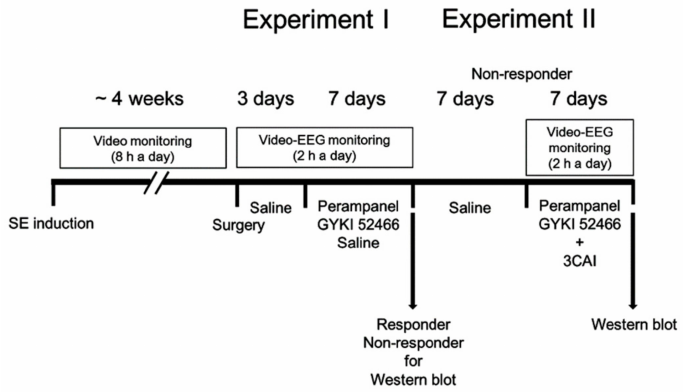
Figure 1. Scheme of the experimental design in the present